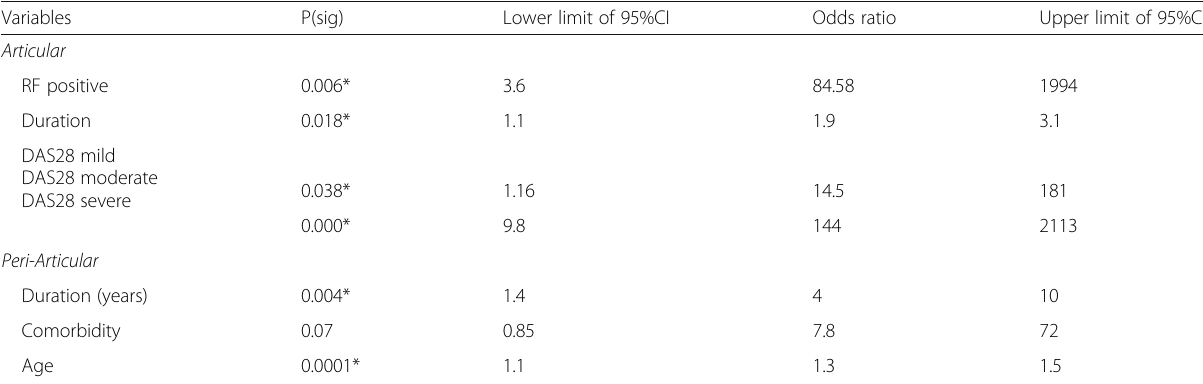
Table 5 Logistic regression for predicting variables for both articular and peri-articular subclinical US shoulder joint changes in RA patients Variables